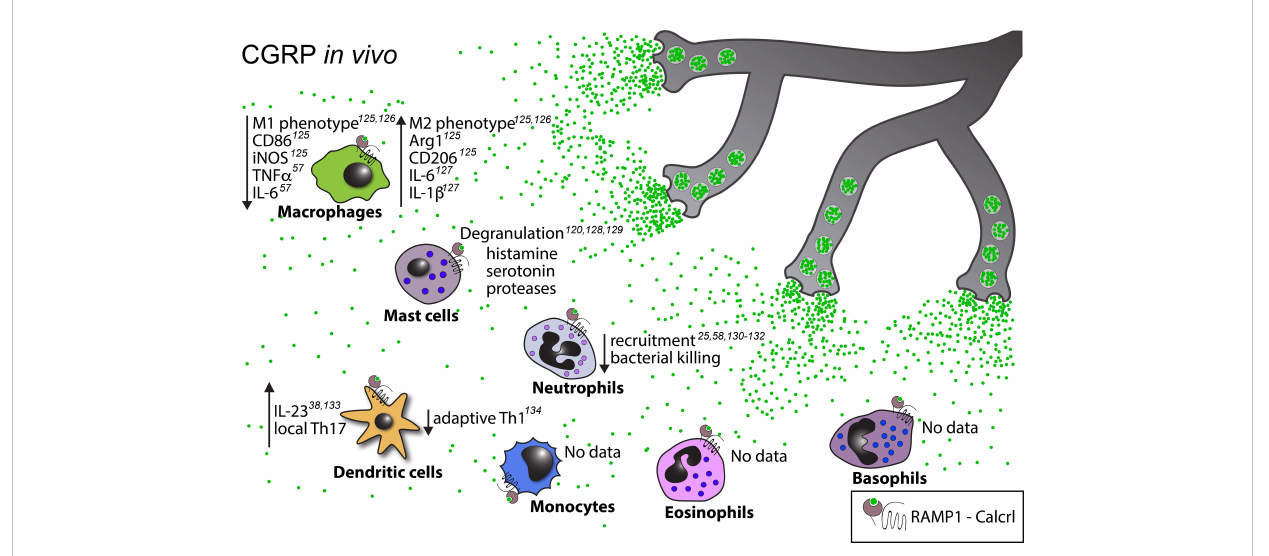
FIGURE 4 Known in vivo effects of CGRP on myeloid cells. Upward pointing arrows signify upregulation/activation, downward facing arrows signify